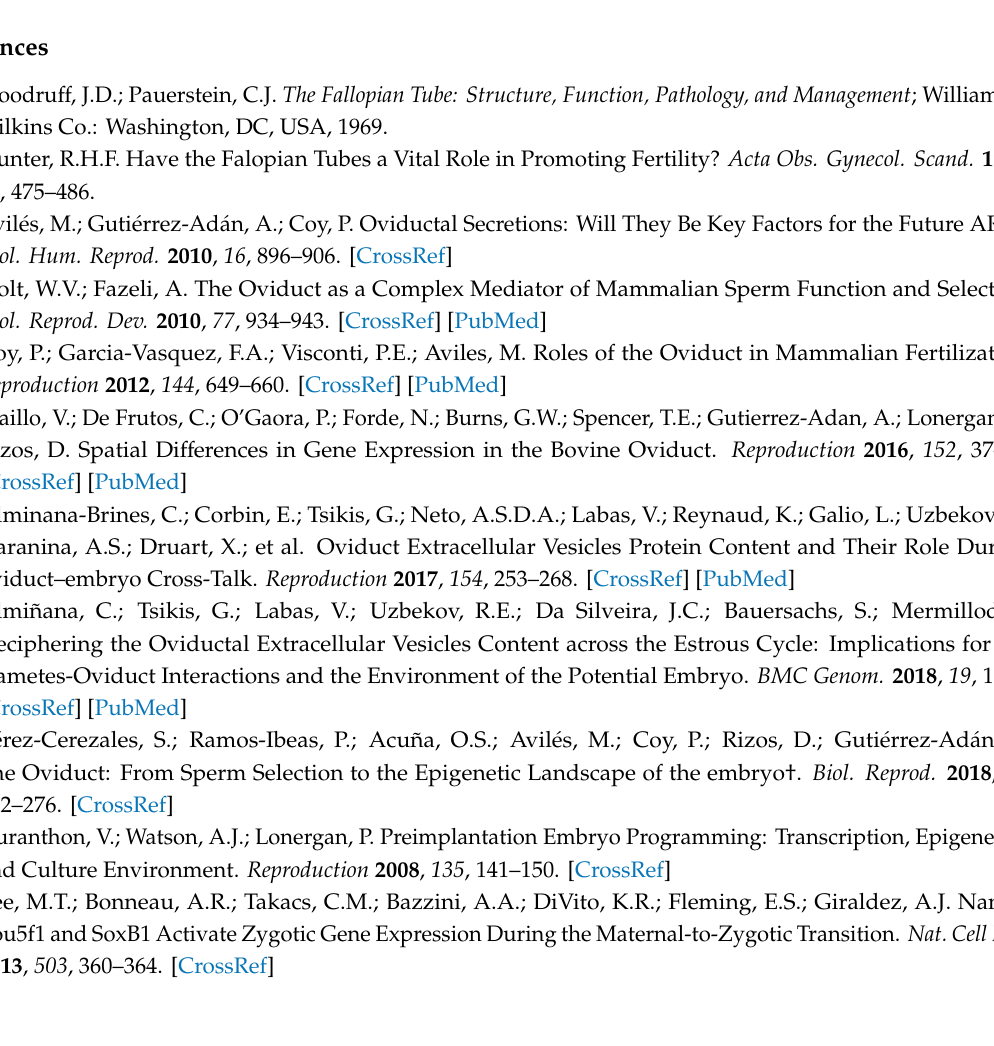
Table S1: Deletes peptides Sus scrofa , Table S2: DEGs oviduct cow + mare + so, Table S3: Exosomal vs secreted, Table S4: Conserved interactions, Table S5: Human interactions, Table S6: Cow interactions, Table S7: Pig